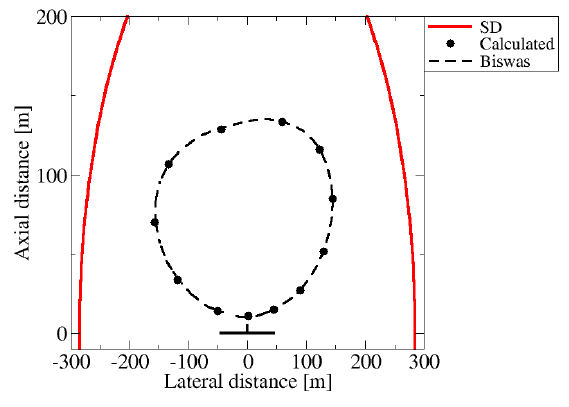
Figure 2. Impact positions for different azimuthal starting angles. Comparison with the computations of Biswas et al. [8].